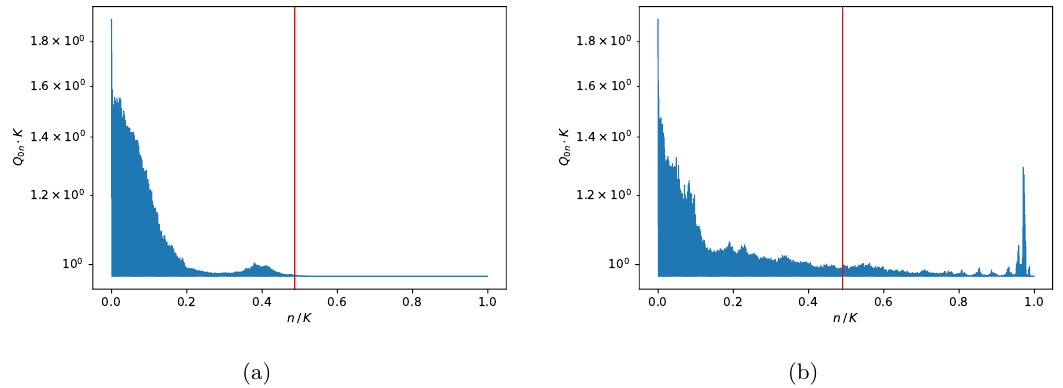
Figure 12. K-complexity saturation value for constant operator evolving under Hamiltonian taken from a GOE ensemble (left) and Hamiltonian with Poissonian statistics (right), both computed at D = 32 . Note that both cases exhibit saturation value close to K/ 2